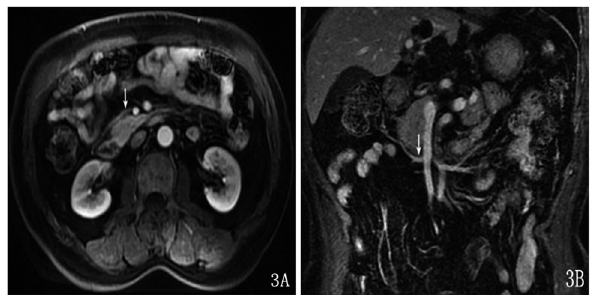
Figure 1. The signal intensity of the transverse-mesocolon adipose tissue was uniform (white arrow) and consistent with the subcutaneous fat (black arrow) signal on the T2-weighted image.